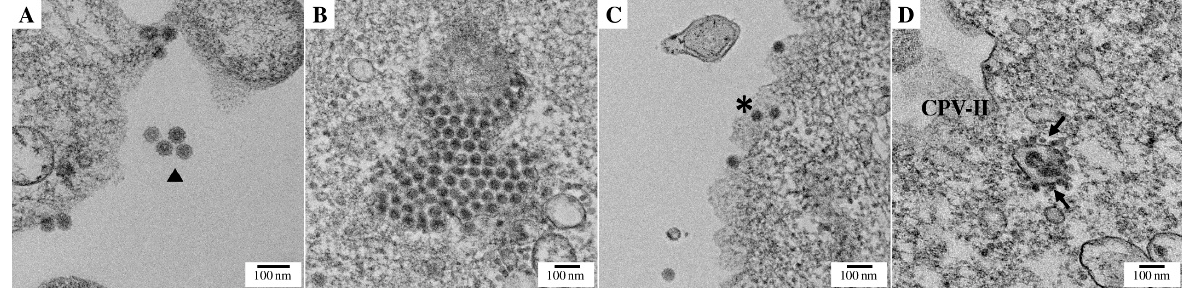
Figure 3. Chikungunya virus pACNR-CHIKV plasmid induces replication and assembly of viral infectious particles. Vero E6 cells infected with Chikungunya virus at a MOI of 1 were assessed at 24 h post-infection. TEM images show Chikungunya ( A ) four extracellular virions ( ▲ ), ( B ) a viral factory, ( C ) four virions budding from a membrane ( * ) , and ( D ) type-II cytopathic vacuoles (arrow, CPV-II). Bar, 100 nm.